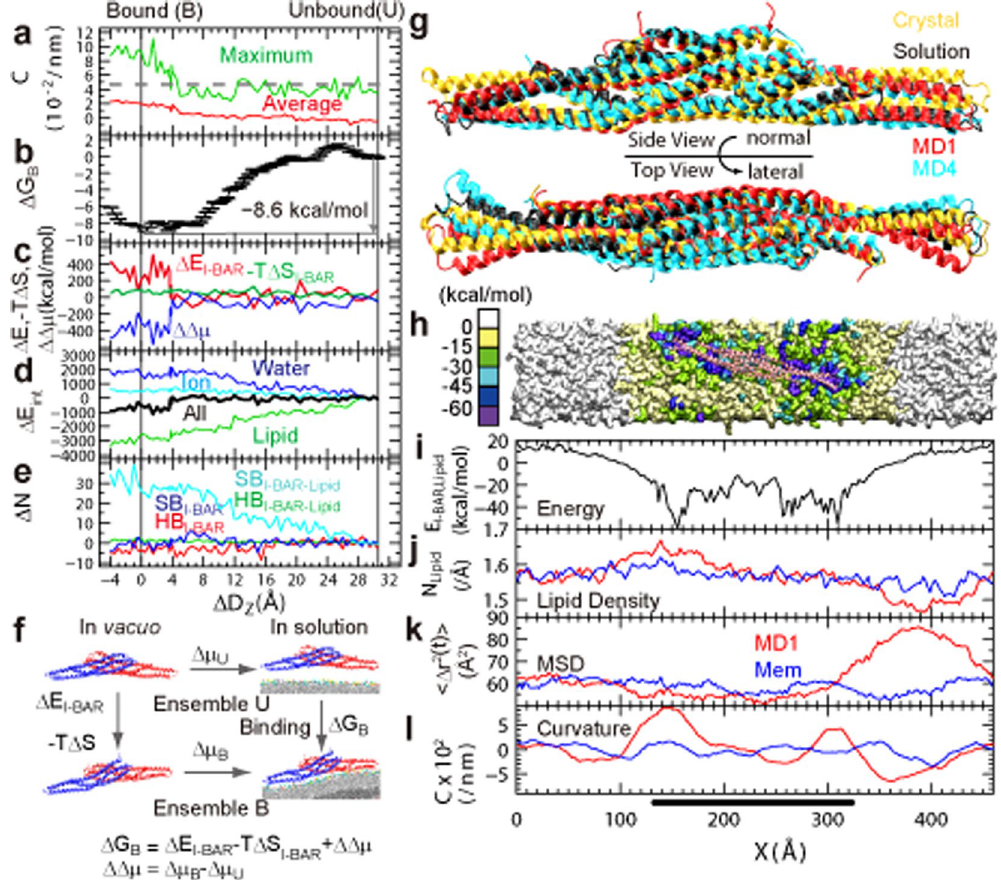
Figure 3. Free energy analysis of I-BAR binding. ( a ) Curvature, ( b ) binding free energy Δ G B , ( c ) free energy components Δ E I-BAR , − T Δ S I-BAR , and ΔΔμ , ( d ) components of Δ E int , ( e ) the number of hydrogen bonds and salt bridges within I-BAR and between I-BAR and the lipids, as a function of Δ D Z . In ( a ), the broken line shows experimentally deduced curvature 9 . ( f ) Thermodynamic cycle of binding/unbinding. ( g ) The structures of I-BAR in the crystal, in solution, and from MD1 and MD4. ( h ) Interaction energy between I-BAR and each lipid headgroup mapped on the XY plane. ( i ) Interaction energy between I-BAR with the lipid headgroups integrated along the Y-axis. ( j ) Lipid local density (N lipid ), ( k ) mean square displacement (MSD, < Δ r 2 (t) > ) of the lipids in bilayer lateral direction at time t = 10 ns, and ( l ) curvature (C) as a function of the X coordinate. The horizontal bar in the bottom indicates the position of I-BAR. The results shown in ( h ) to ( l ) were obtained from 107~137 ns in MD1 and 140~170 ns in membrane only system. Center of mass for the headgroup was used to calculate lipid density, MSD, and curvature. The lipid densities and MSDs were averaged over the range of ± 48.3 Å. The molecular graphics was created by VMD 57 Electrostatically-driven I-BAR Binding and Membrane Deformation. The maximum and average curvatures, C max and C ave , and free energy, Δ G B , of I-BAR binding were calculated as a function of the center of mass distance Δ D Z between I-BAR and the membrane (Fig. 3a,b). The origin of Δ D Z was set to the global free energy minimum, and the second minimum was positioned at Δ D Z = 3.5 Å. Δ G B is − 8.6 kcal/mol at Δ D Z = 0, compared to a value at Δ D Z = 30.5 Å. The free energy differences are relatively small (~2 kcal/mol) in the range = − 3~8 Å, and the entire I-BAR is bound to the lipid bilayer. A decrease in Δ G Δ D Z B correlated with an increase in curvature (Fig. 3a,b). The macroscopic curvature of the membrane deduced from the diameter of the mem- brane tubule induced by I-BAR observed using transmission electron microscopy 9 , C exp , is 4.7 × 10 − 2 nm − 1 (bro- ken line in Fig. 3a). The curvatures, C max = 9.2 × 10 − 2 nm − 1 and C ave = 2.0 × 10 − 2 nm − 1 at the binding free energy minimum correspond to 22 and 100 nm in diameter, respectively. C max roughly indicates the maximum limit of microscopic deformation that a single I-BAR can induce locally, and C ave gives a slightly more macroscopic average. The membrane deformation observed in this work can be considered as an initial process of the global deformation induced by the binding of the first I-BAR. Furthermore, given that C exp provides a macroscopic value due to the binding of multiple I-BAR, the order C max > C exp > C ave is reasonable. The mechanism underlying binding and deformation were investigated by conducting free energy compo- nent analysis, Δ G B = Δ E I-BAR − T Δ S I-BAR + ΔΔμ , based on the thermodynamic cycle (Fig. 3c–f). Here, ensem- bles U and B indicate the I-BAR structural ensembles generated as membrane unbound ( Δ D Z = 30.5 Å) and bound states (0 Å) in solution, respectively. Δμ U and Δμ B ( ΔΔμ = Δμ B − Δμ U ) represent the free energy of